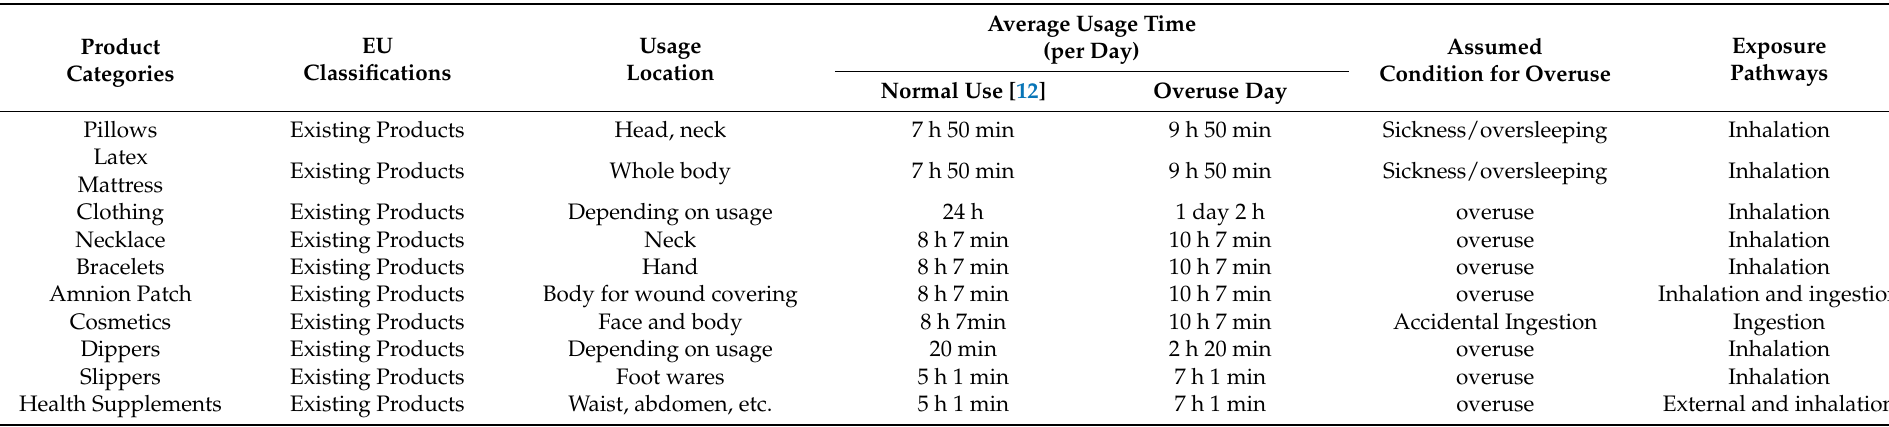
Table 1. Summary of hypothetical usage scenarios and exposure